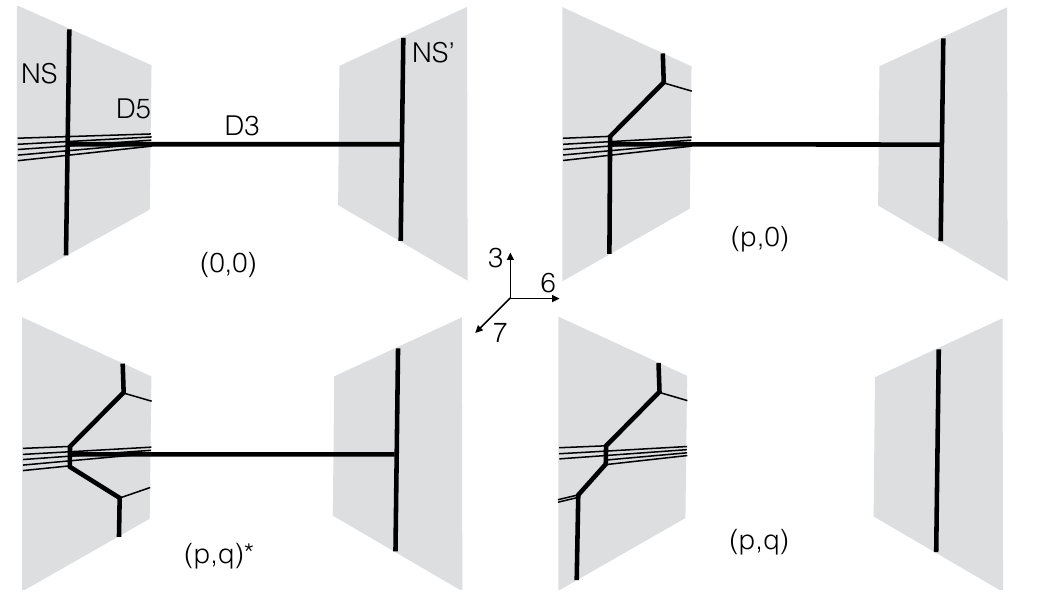
Figure 4 . The D3-D5-NS5 brane picture summarizing the dualities of [8]. x 3 is a compact direction.